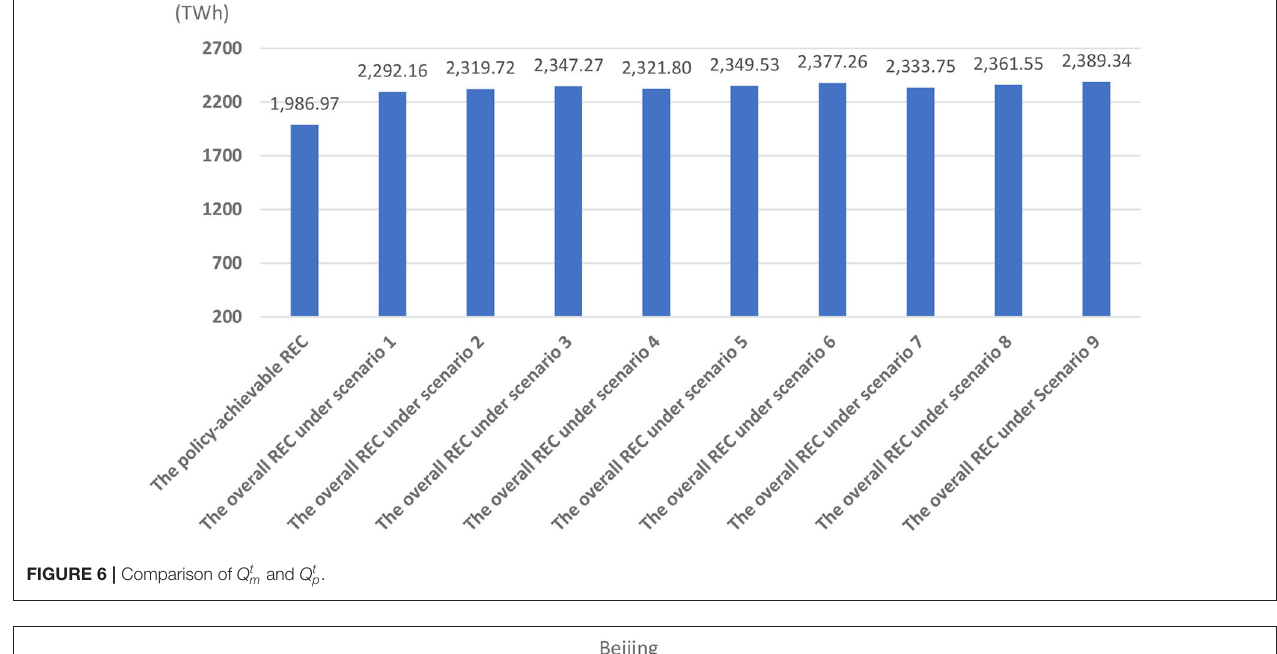
FIGURE 6 | Comparison of Q t m and Q t p .